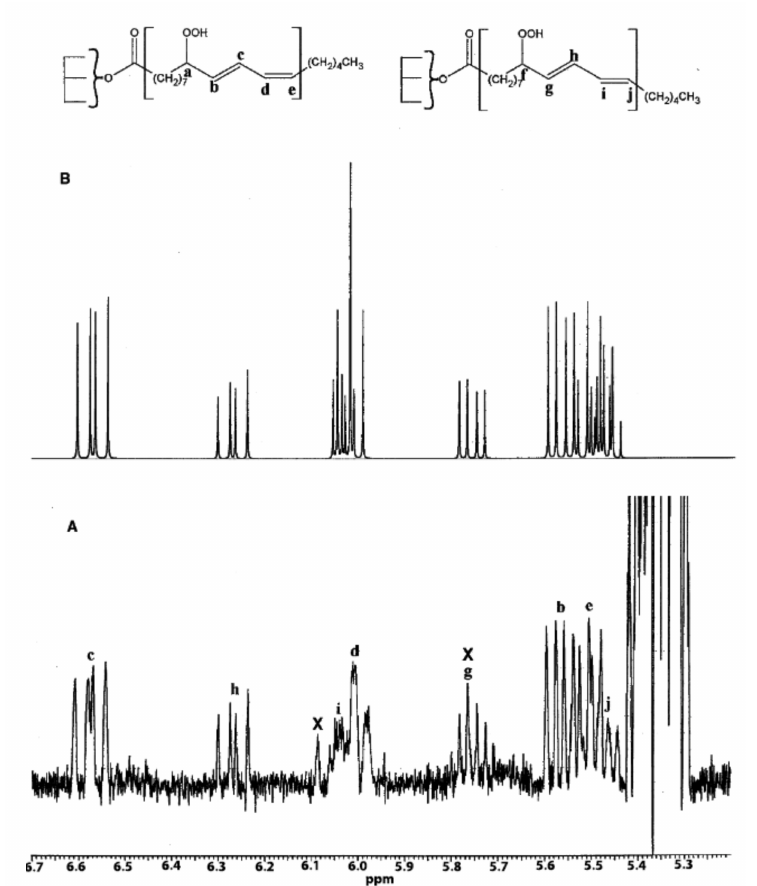
Figure 24. Selected 5.20–6.70 ppm regions of ( A ) an experimental 400 MHz 1 H-NMR spectrum of an autoxidized sample of 1,3-dilinolein (in CDCl 3 solution), and ( B ) a corresponding computer- simulated spectrum. 1 H nuclei labels of isomeric conjugated hydroperoxyl dienes correspond to those given in the molecular structures depicted above the spectra. “x” indicates spectral artifacts. Reprinted with permission from [111]. Copyright 1999,